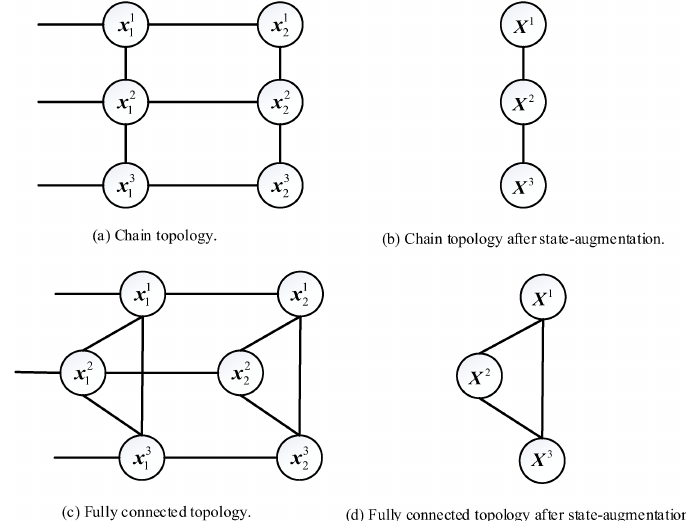
Figure 2. Factor